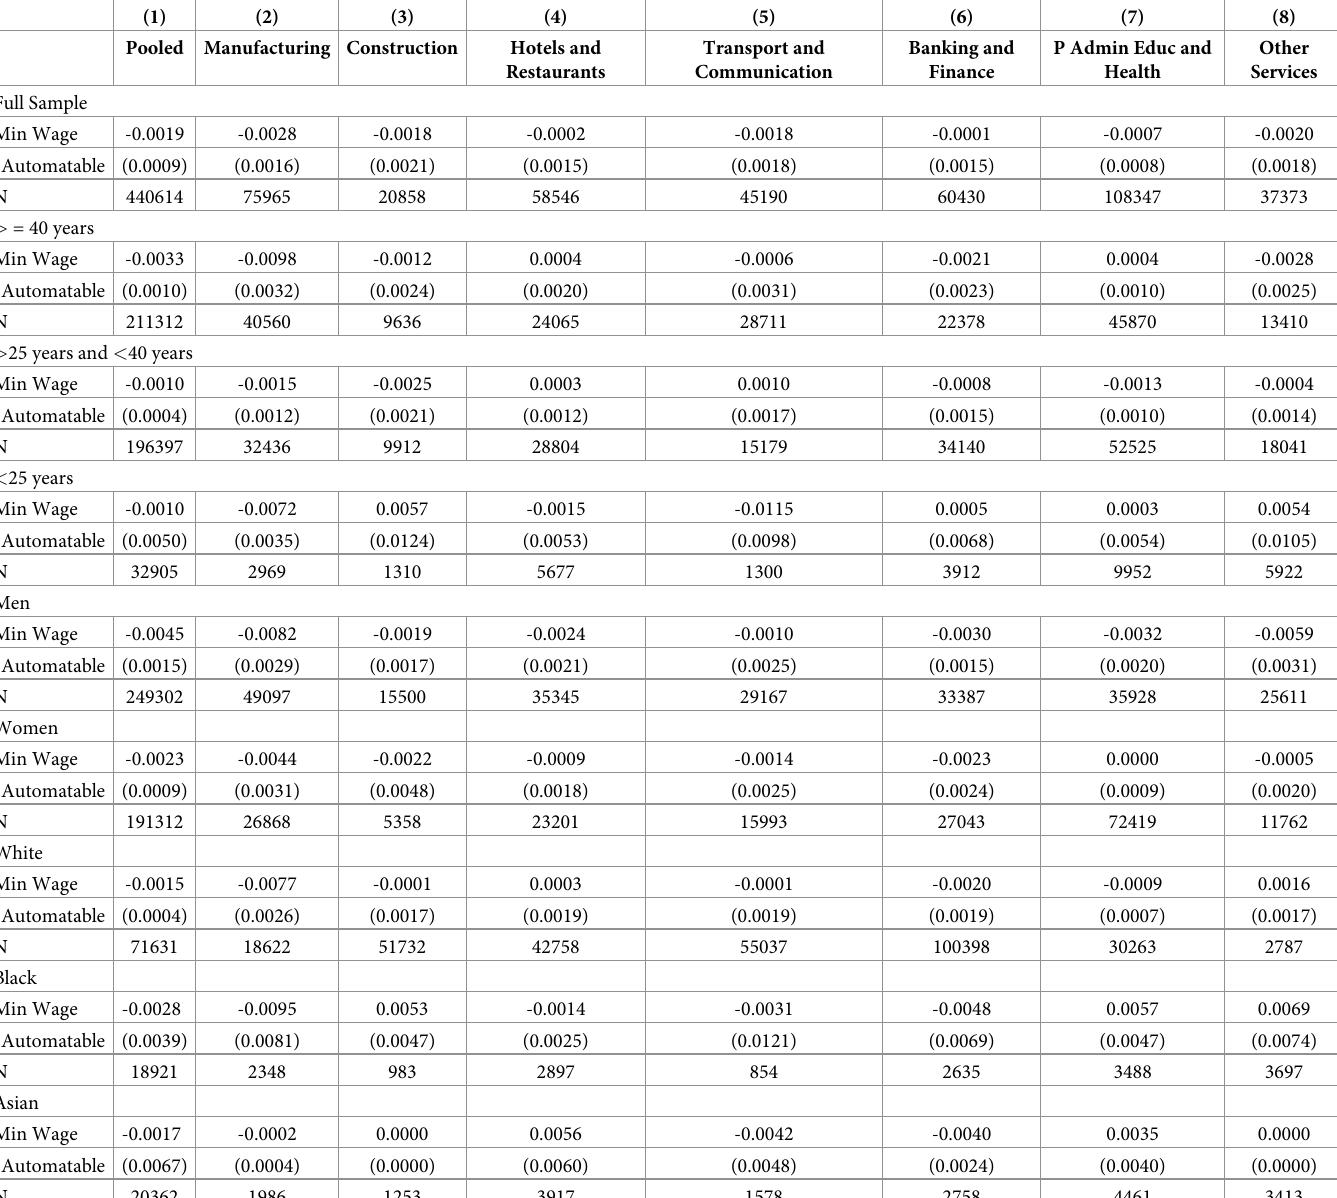
Table 5. Individual level estimates: Probability of being employed in the next